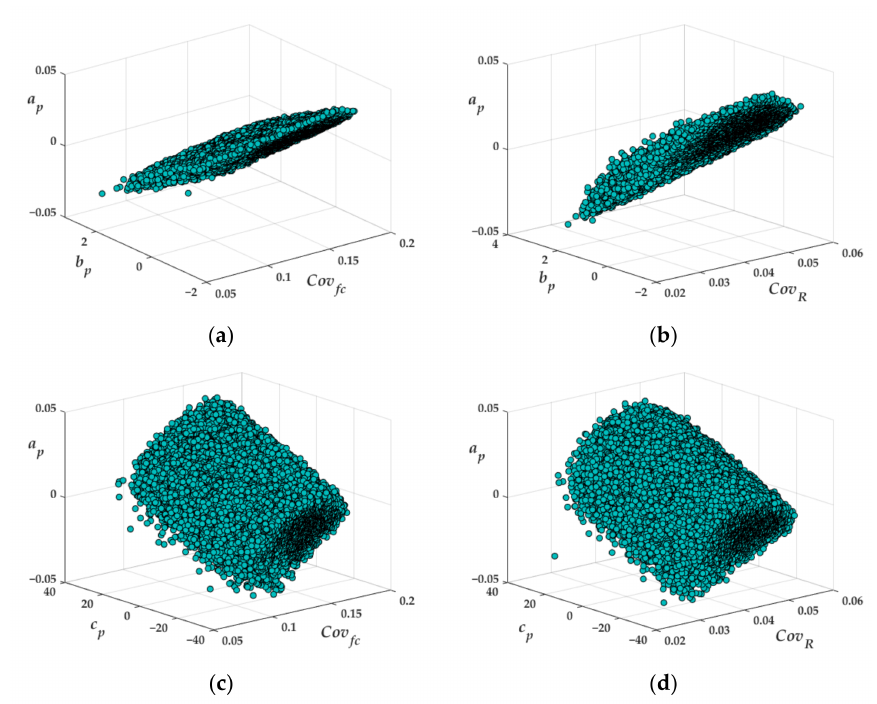
Figure 9. Relationship between the coefficients of the calibrated polynomial empirical laws a p , b p , c p and the coefficients of variation for m = 15: ( a ) plot a p vs. b p and the coefficient of variation of the concrete strength Cov fc ; ( b ) plot a p vs. b p and the coefficient of variation of the rebound index Cov R ; ( c ) plot a p vs. c p and the coefficient of variation of the concrete strength Cov fc ; ( d ) plot a p vs. c p and the coefficient of variation of the rebound index Cov R .